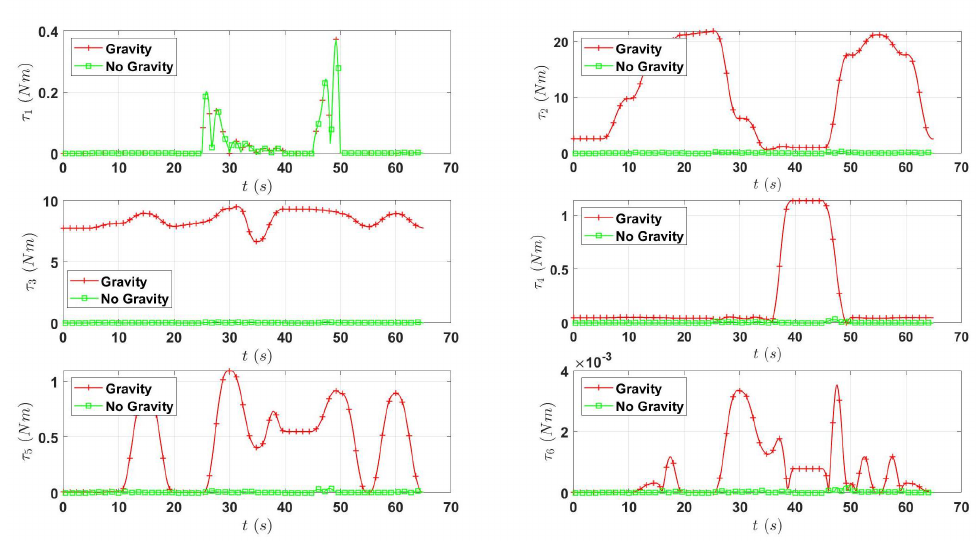
Figure 9. Plot of the torque generated for a trajectory for each